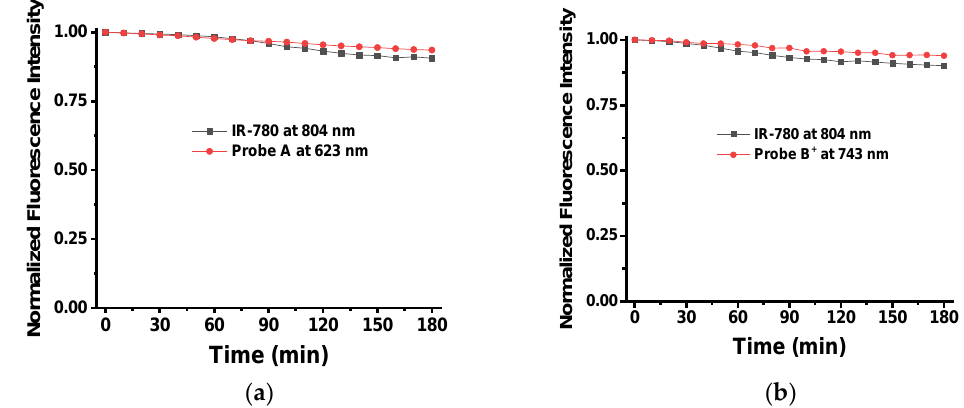
Figure 5. Fluorescence intensity of probes A ( a ) and B + ( b ) under continual excitation of 450 nm for probe B + and 550 nm for probe A .